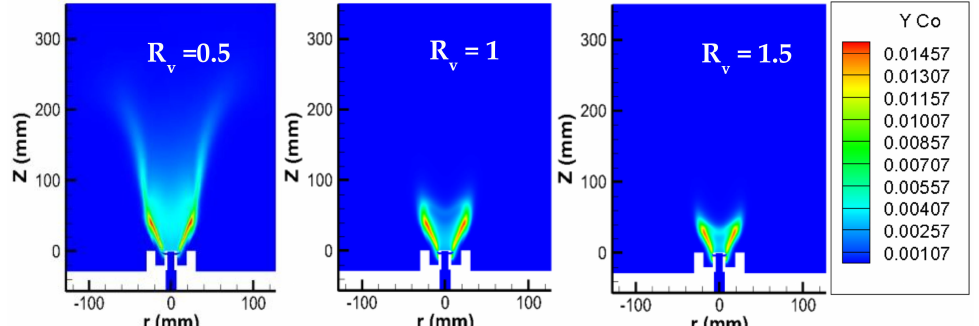
Figure 13. Computed contours of CO mass fractions obtained in the plane (X, Z).